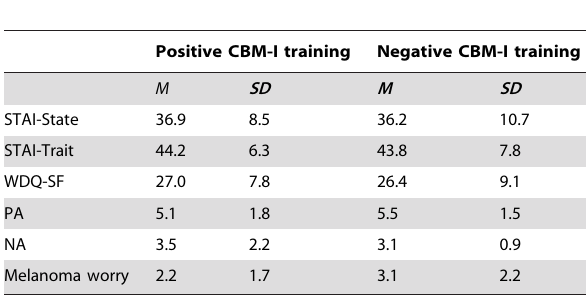
Table 1. Comparisons of the two training conditions at baseline on anxiety, worry and state